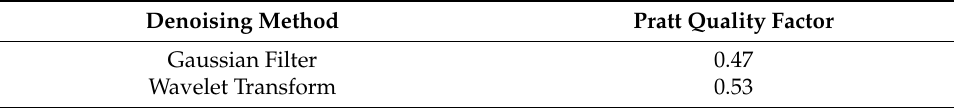
Table 3. Figure of merit for edge detection.